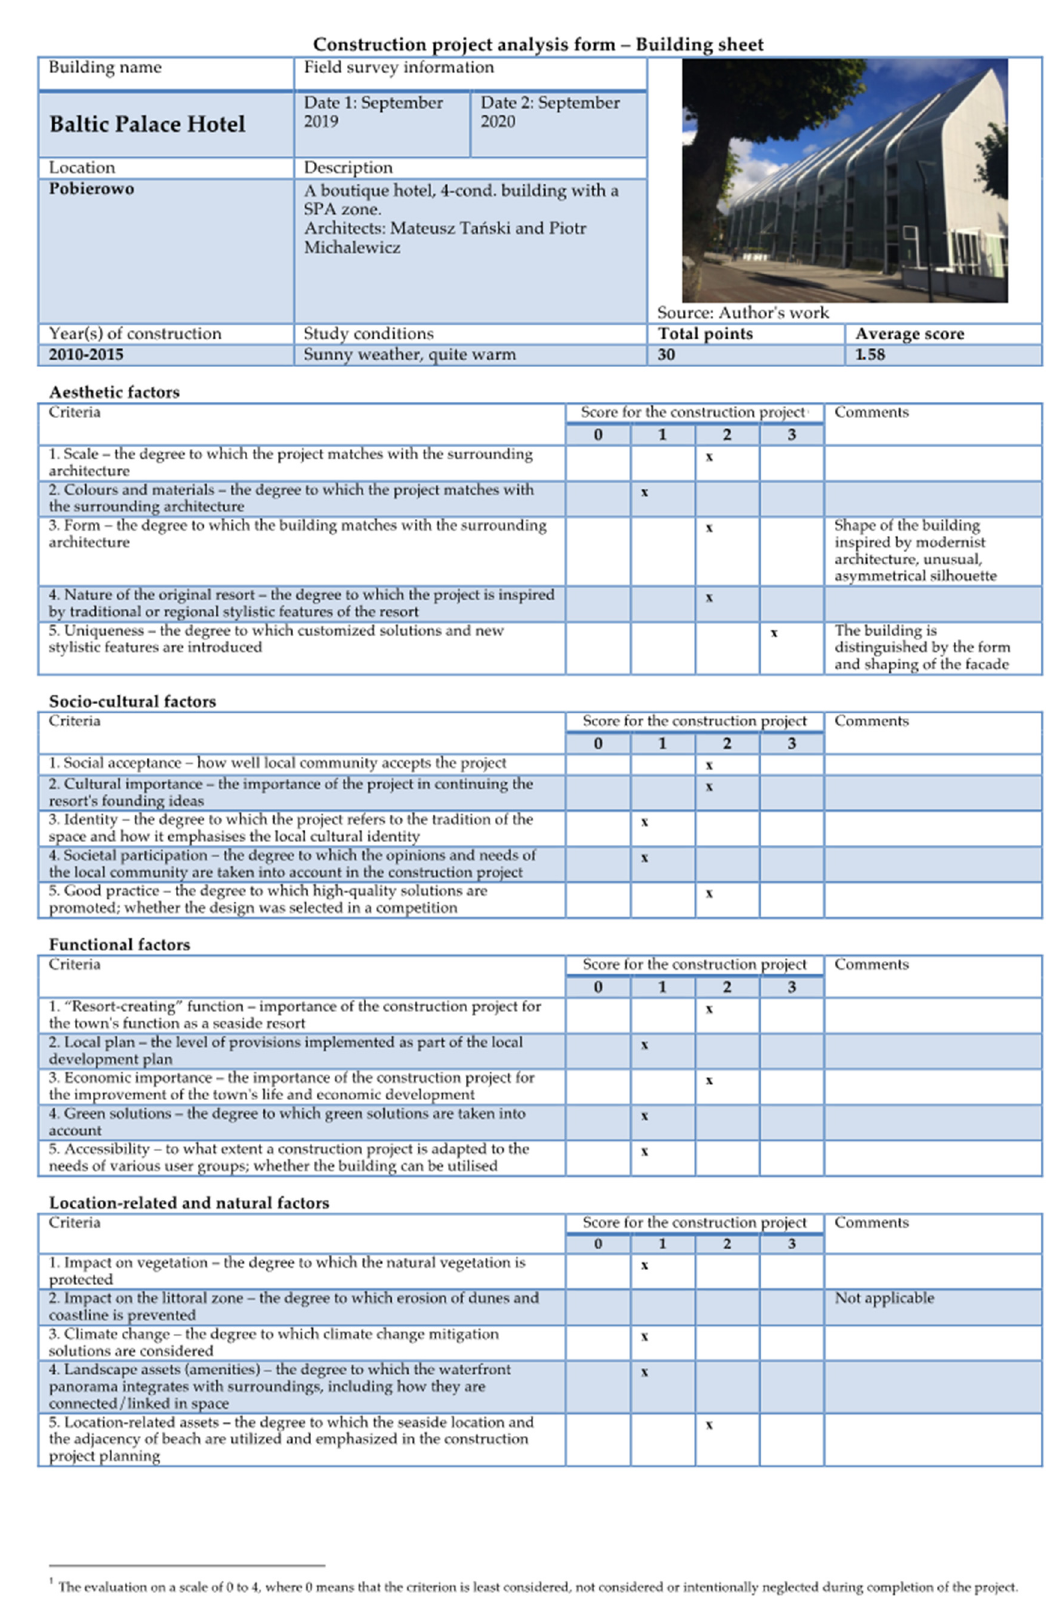
Figure A1. Baltic Palace Hotel in Pobierowo. Building sheet.